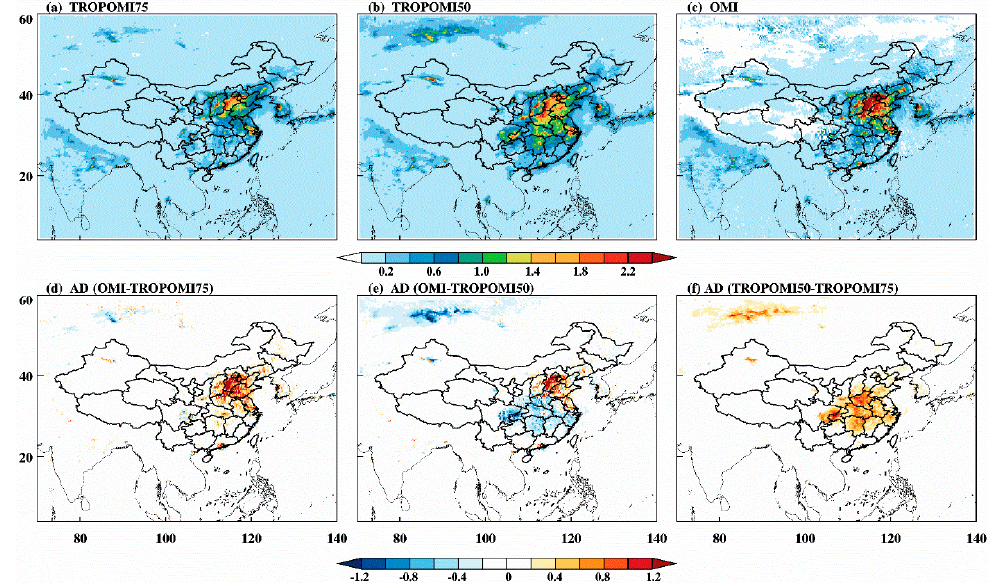
Figure 2. Exemplary monthly mean maps (0.25° × 0.25° grid) of ( a ) TROPOMI75, ( b ) TROPOMI50, ( c ) ( c ) OMI tropospheric NO 2 VCDs as well as ( d – f ) their absolute di ff erences (AD) (units: 10 16 molec cm − 2 ) OMI tropospheric NO 2 VCDs as well as ( d – f ) their absolute differences (AD) (units: 10 16 molec cm –2 ) for November for November 2018.